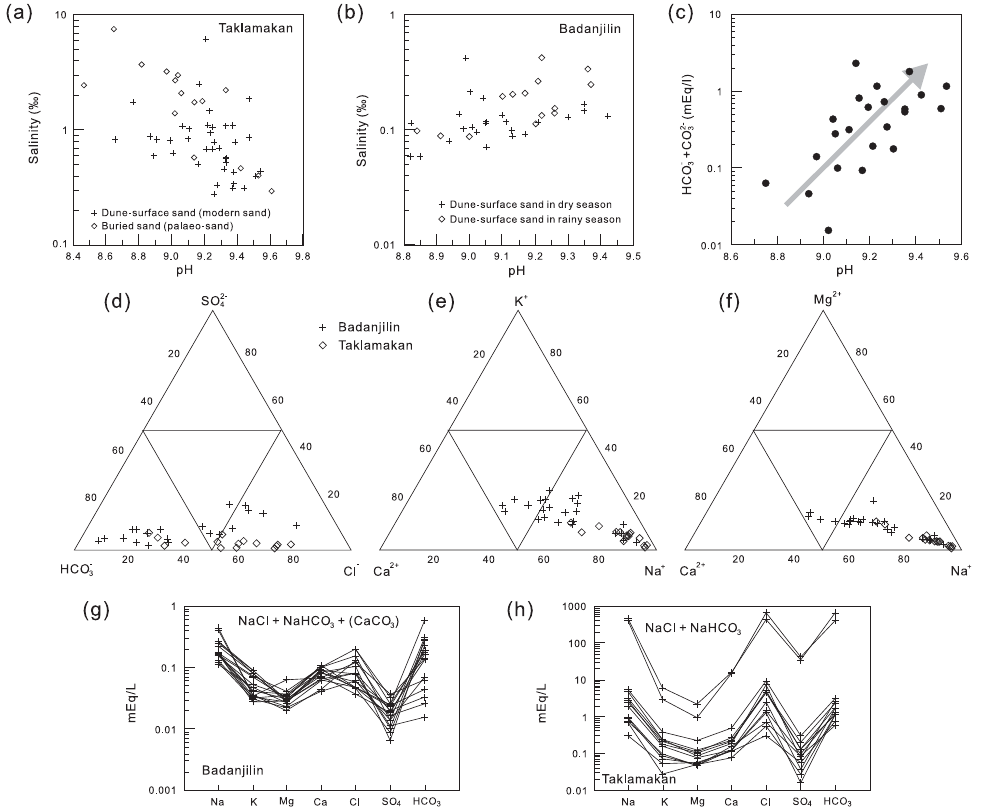
Figure 4. Salinities vs. pH of sediment solutions: (a) dune-surface sediments (modern sediment) and buried-dune sediments (palaeo- sediment) in the Taklamakan Desert, (b) dune-surface sand samples collected in different climatic seasons (dry and wet) in the Badain Jaran Desert. (c) Carbon-bearing ions vs. pH; triangular plots of major anions (d) and cations (e, f) of the soluble salts in mEqL − 1 unit. Distribution patterns of the major ions of the soluble salts in the aeolian sediments from (g) the Badain Jaran Desert and (h) the Taklamakan